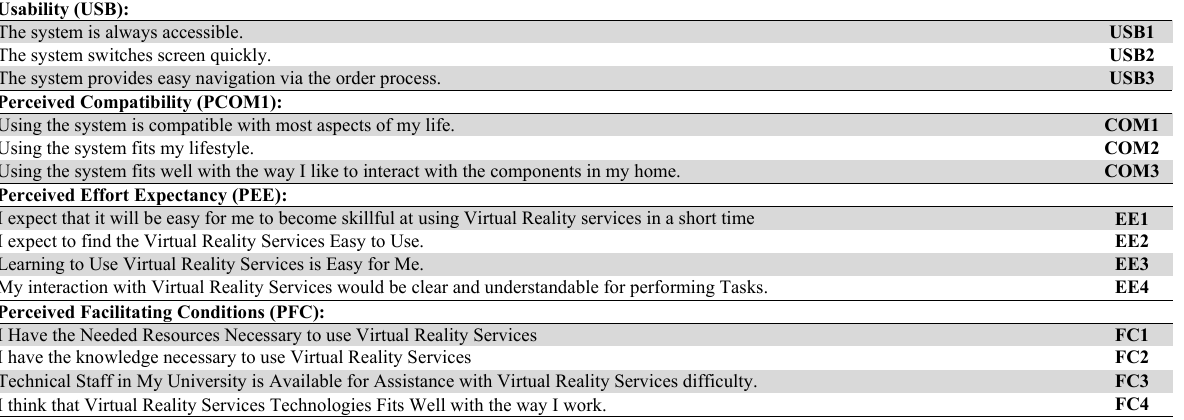
TAM Factors and